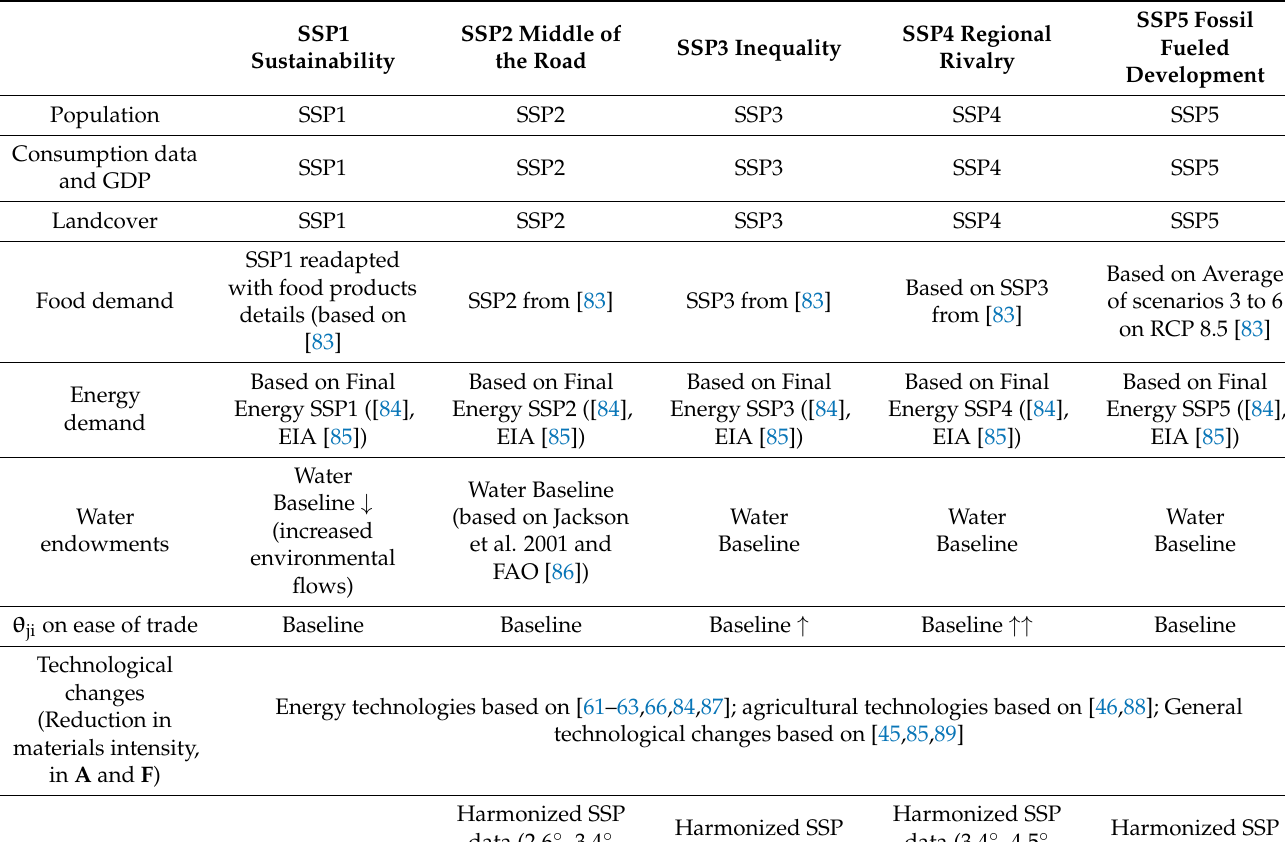
Table 1. Sources for scenarios and how key factors change in each of